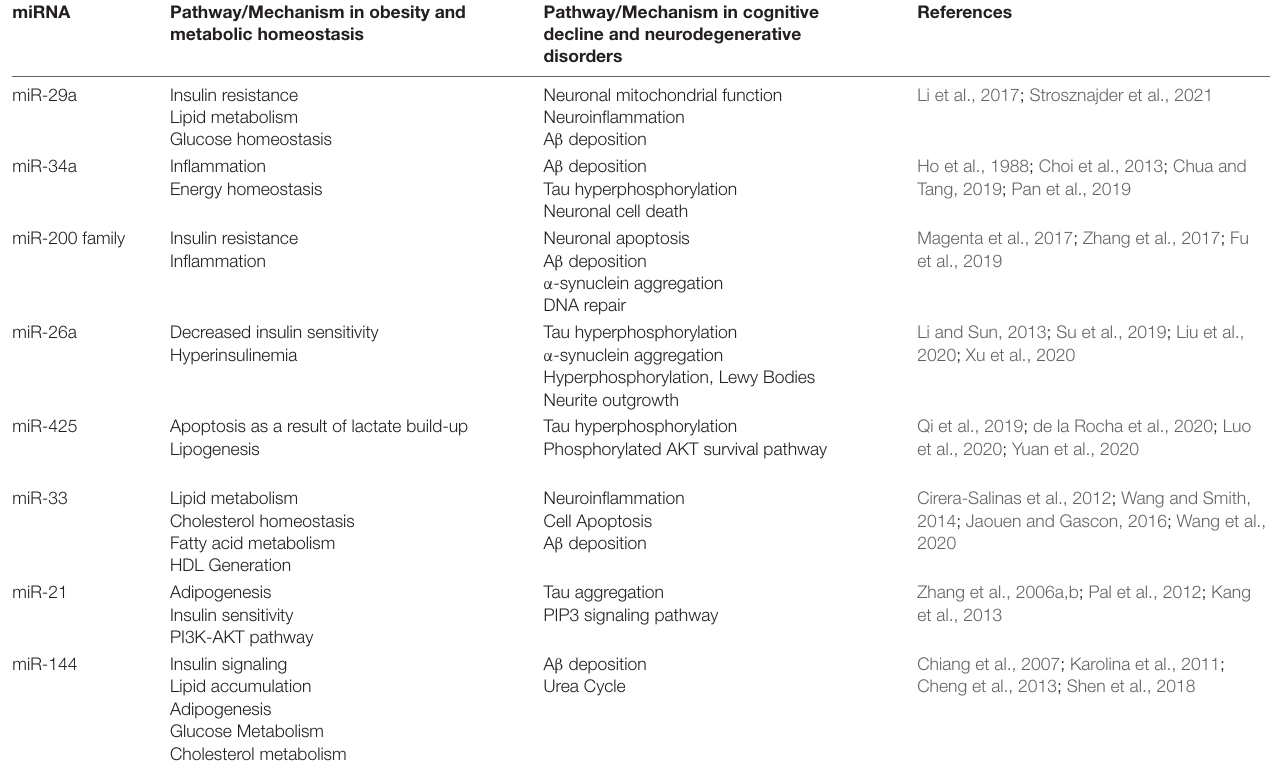
FIGURE 2 | Schematic representation demonstrating the mechanistic role of miRNAs in obesity associated neurodegeneration. Obesity propagates inflammation, lipid accumulation and alters insulin signaling through the transcriptional role of respective miRNAs. These miRNAs further mediate neuroinflammation, apoptosis and accumulation of A β through distinct pathways, along with alterations associated with obesity which further results in cognitive decline and neurodegeneration. TABLE 2 | Summary of mechanistic action of miRNAs in obesity associated cognitive decline and neurodegenerative disorders.